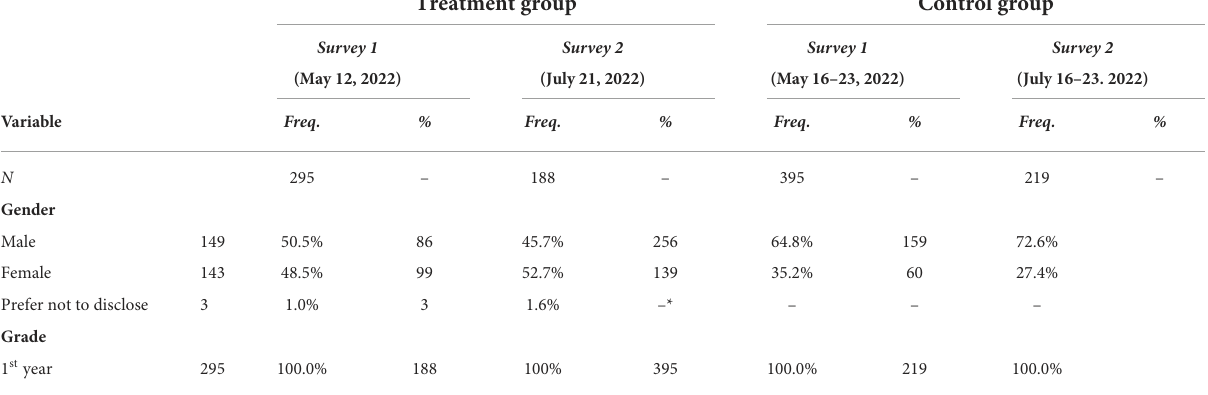
TABLE 1 Demographic information of respondents.